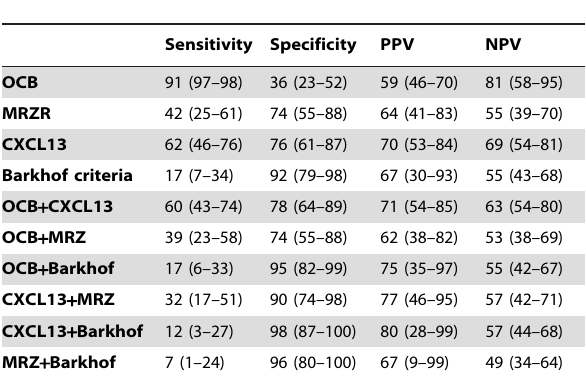
Table 2. Sensitivity, specificity, positive (PPV), and negative (NPV) predictive value in percent (exact 95% confidence interval in brackets) for CSF and MRI parameters regarding conversion of clinically isolated syndrome to definite multiple